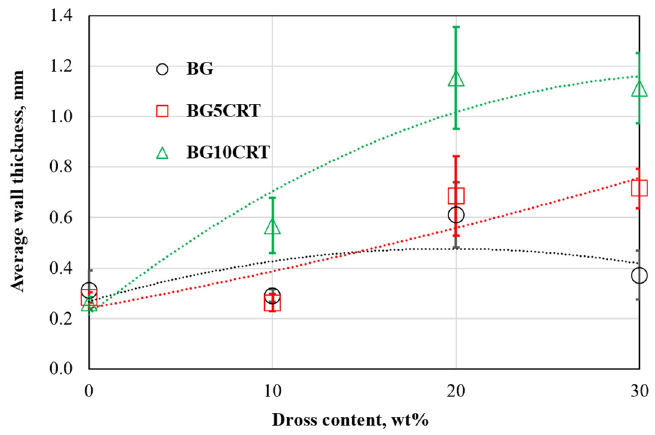
Figure 7. Average wall thickness of the foam glasses.